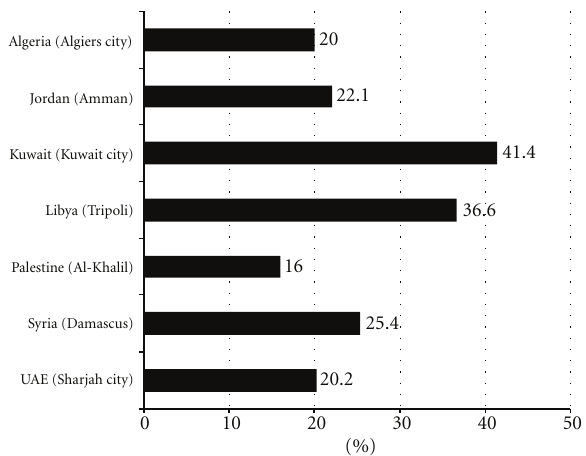
Figure 2: Comparison in prevalence of overweight and obesity among female adolescents (15–18 years) in seven Arab